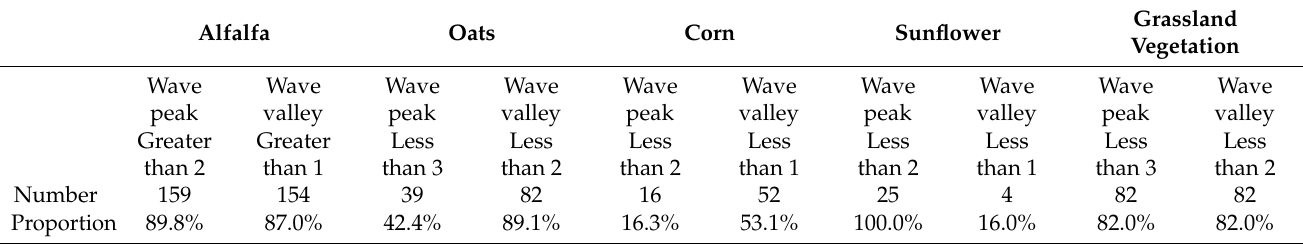
Table 8. Wave peak and valley numbers and proportions obtained from the NDVI series of different vegetation types derived from the Sentinel-2